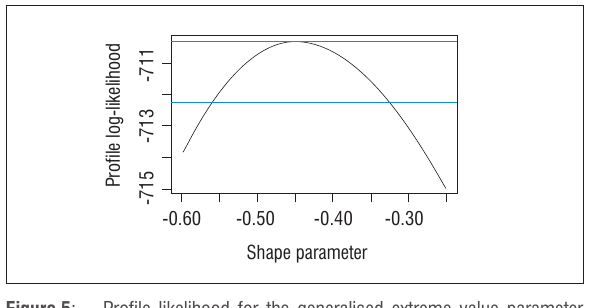
Figure 5 : Profile likelihood for the generalised extreme value parameter shape, for minimum annual rainfall for Zimbabwe for the period 1901–2009.